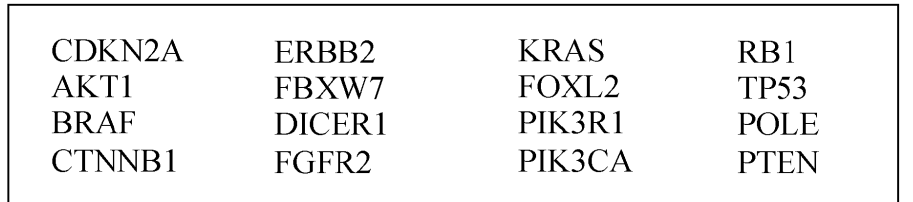
Figure 1. Genes tested via Next-Generation Sequencing (NGS). Once this selection was achieved, 118 cases between 2019 and 2022 were included in this